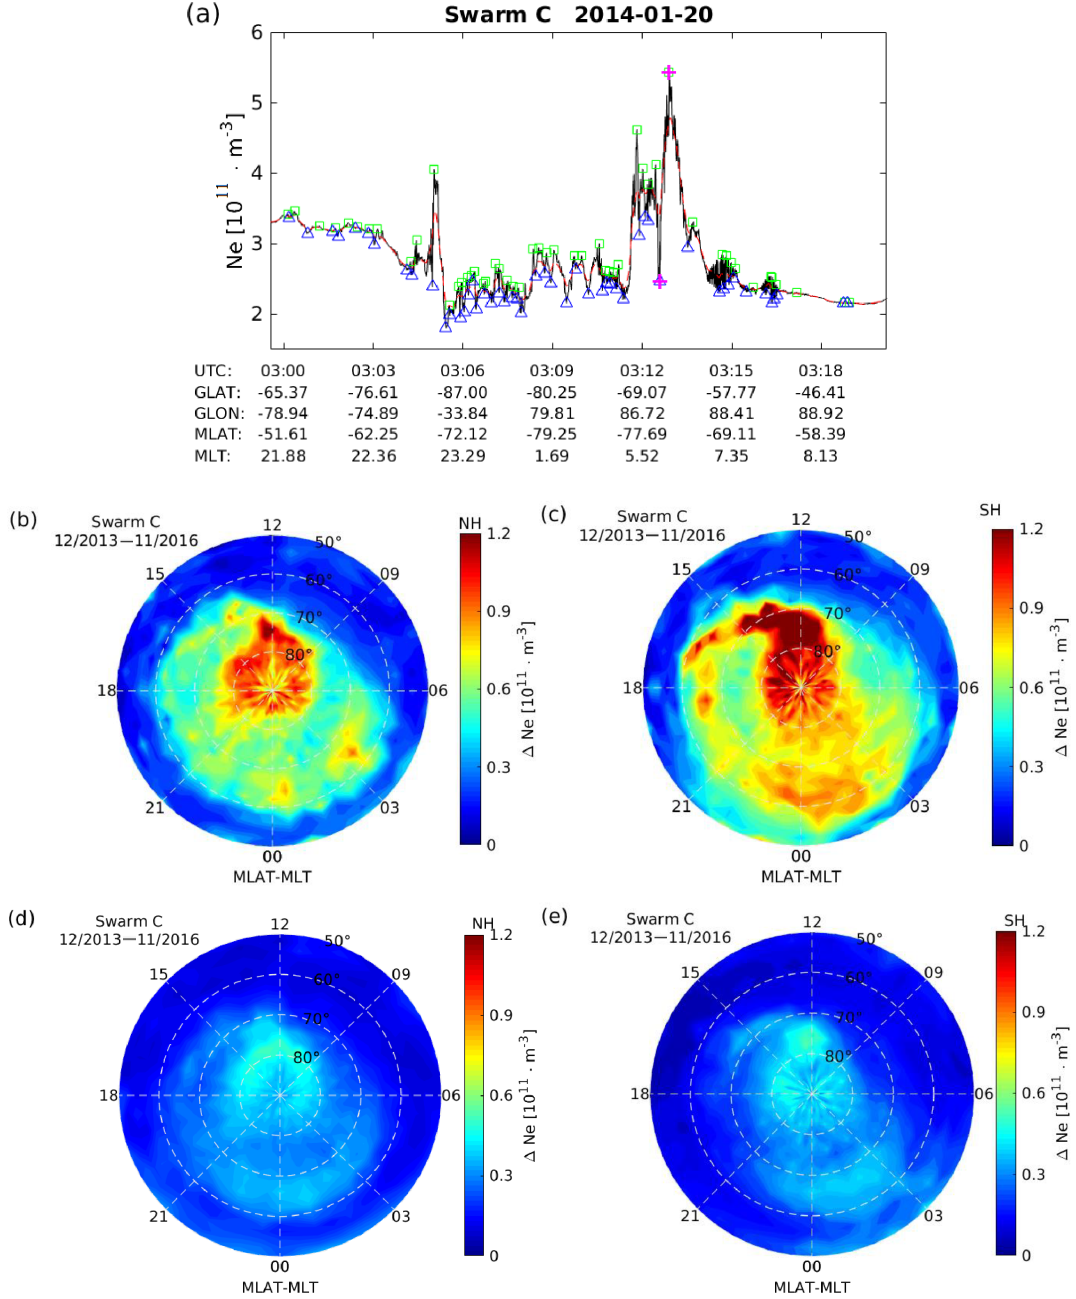
Figure 4. (a) One example of how to determine the high-latitude plasma density gradient ( (cid:49) Ne ) along track from the in situ Ne measurements of Swarm C. The MLAT vs. MLT distribution of (cid:49) Ne in the (b) northern and (c) southern hemispheres, and only the passes with GPS signal loss events observed has been taken into account. (d) and (e) are similar to (b) and (c) but for the passes without GPS signal loss